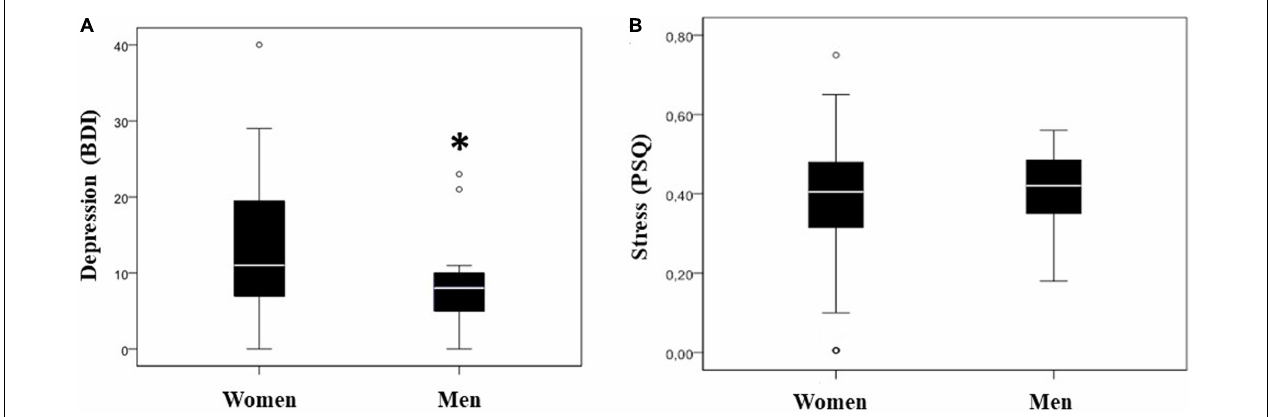
FIGURE 1 | Stress and depression levels. Box and whisker plots of stress and depression levels of the population under study (median is represented with a white bar). Depression levels evaluated by Beck Depression Inventory (BDI) (A) . BDI levels 0–9 for normal range, 10–18 for mild to moderate depression, 19–29 for moderate to severe depression, and 30–63 for severe depression. ∗ p < 0.05 vs. women depression levels. Stress levels evaluated by Perceived Stress Questionnaire (PSQ) (B) . PSQ level 0 means a low level of perceived stress, whereas a value of 1 is a high level of perceived stress.